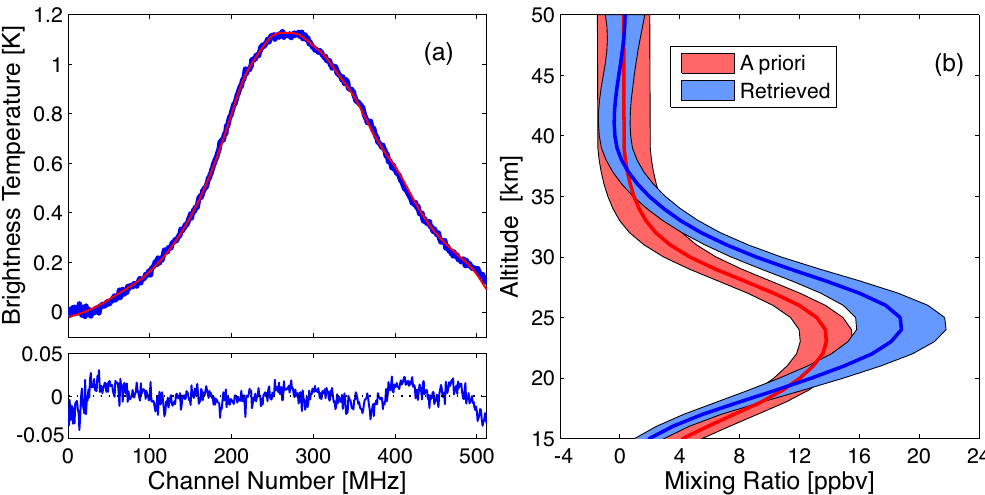
Fig. 5. (a) HNO 3 spectrum observed by the GBMS on 28 April from the Amundsen Scott Base at South Pole. The superimposed red line is the spectrum forward-generated from the retrieved profile. In the bottom panel the spectral residuals (measured spectrum minus calculated spectrum) are shown. (b) HNO 3 profile retrieved from the GBMS spectrum shown in panel (a) . The a priori profile used in the retrieval is also shown (red line). Red and blue shaded areas are, respectively, uncertainties on the a priori profile considered in the retrieval and estimated total error on the retrieved